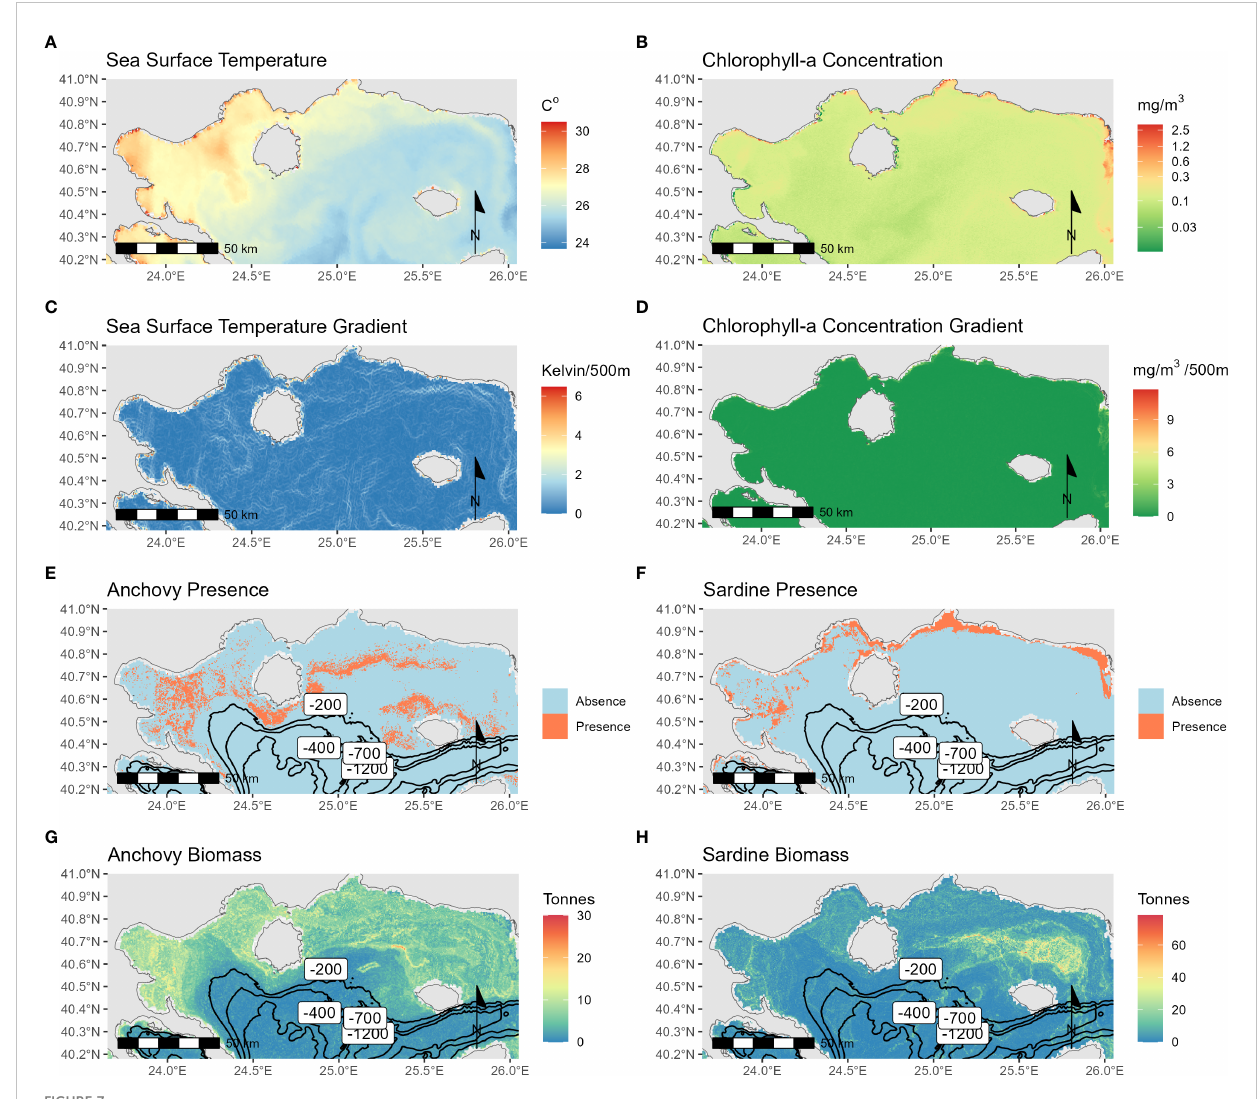
FIGURE 7 Maps for 22/07/2019 showcasing the results of both Random Forest classi fi cation and regression for the Thracian Sea. From left to right and top to bottom, (A) SST, (B) CHL concentration, (C) SST Gradient, (D) CHL concentration Gradient, (E) Anchovy presence classi fi cation results, (F) Sardine presence classi fi cation results, (G) Anchovy biomass regression results and (H) Sardine biomass regression results. Overlayed to the model result maps, the isobaths of -200m, -400m, -700m and -1200m are